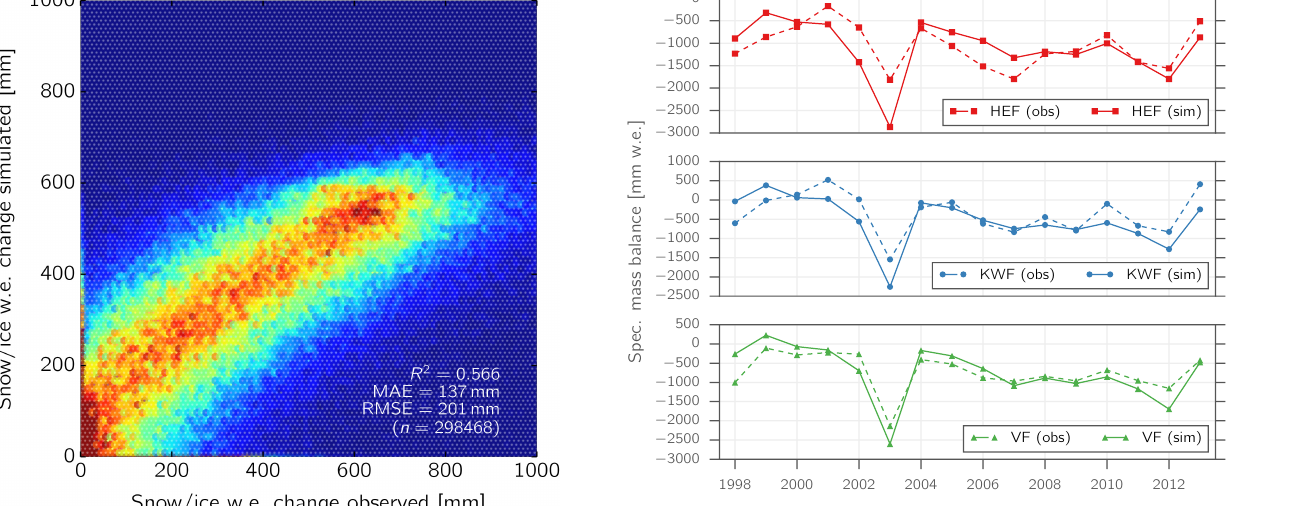
Figure 11. Binned scatter plot (colors represent point density) of observed vs. simulated water equivalent differences for the winter 2010/2011 (8 October to 22 April).